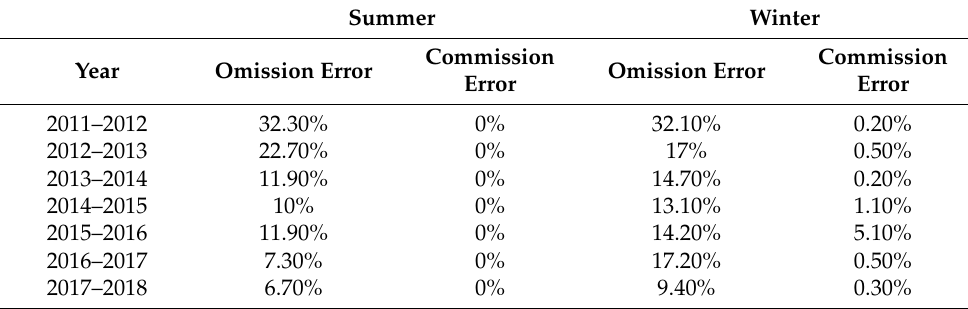
Table 3. The commission and omission errors calculated by comparing classifications using filtered and nonfiltered